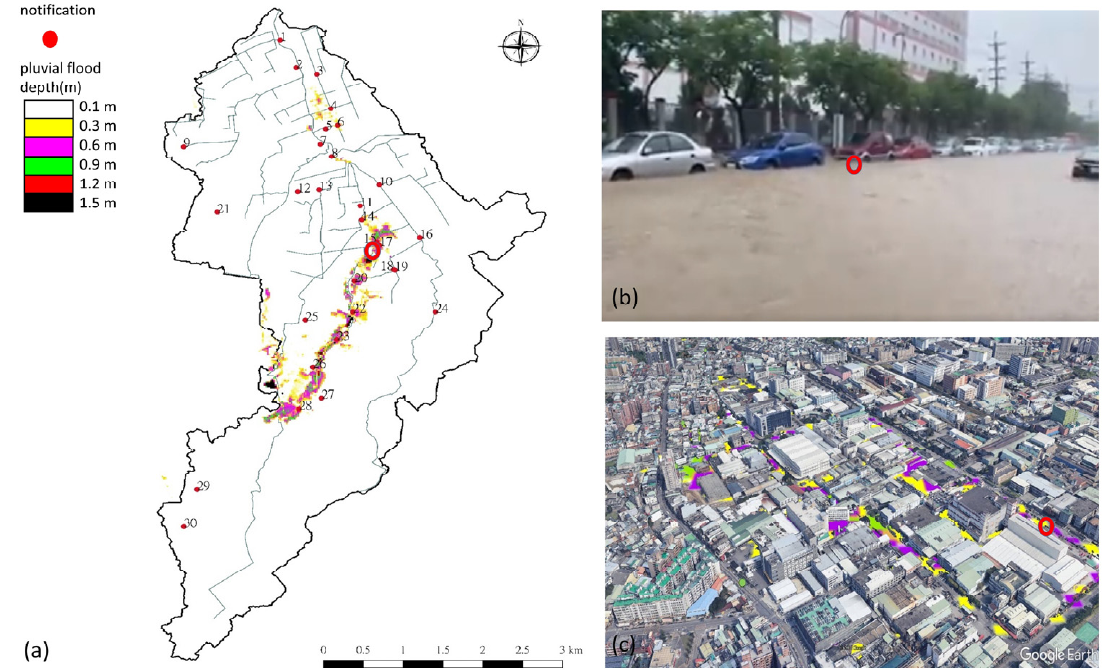
Figure 10. ( a ) The actual measured pluvial flood depths distributed over the study region, ( b ) closed-circuit television (CCTV) image caught at monitoring station 15 and ( c ) the AI simulated / predicted results presented by Google Earth. The red circle indicates the same location, at station 15, in the study region.